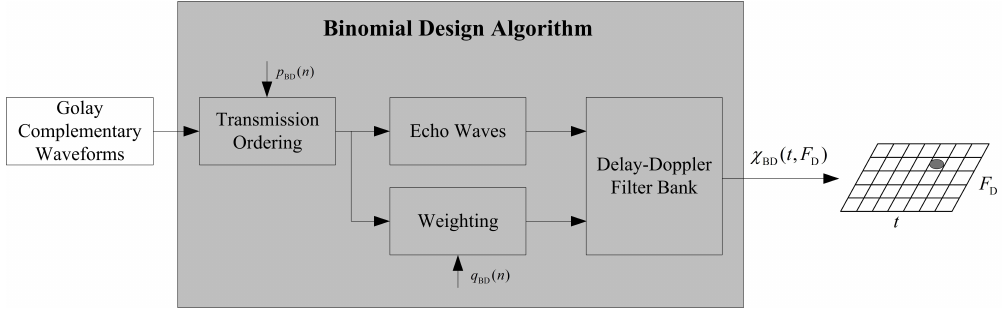
Figure 3. Signal processing structure of the Binomial Design